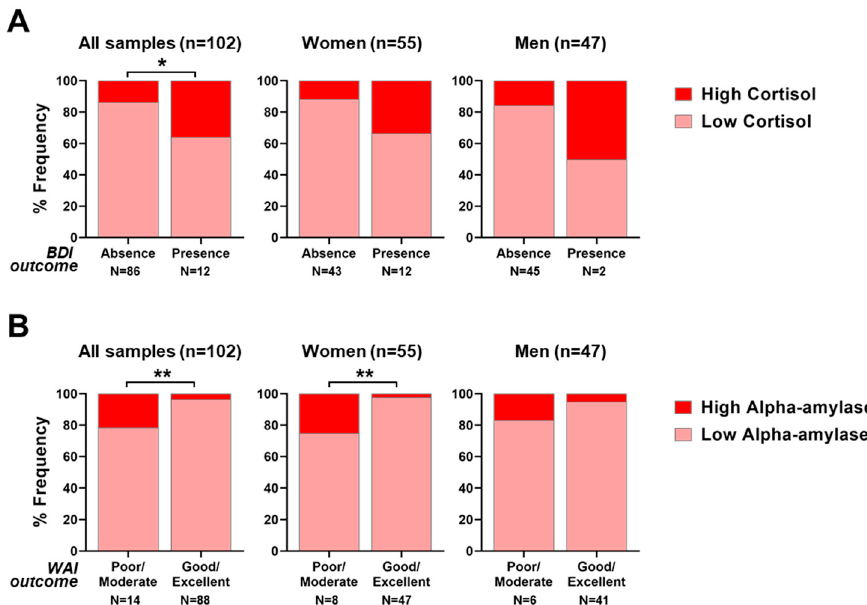
Figure 6. Contingency analyses of psychodiagnostics questionnaires and salivary biomarkers. ( A ) Beck Depression Inventory (BDI) outcome (absence versus presence of depressive symptoms, respectively, left and right columns) in individuals with high (red) versus low (pink) cortisol; considering all samples (left plot), female group (middle plot), male group (right plot). ( B ) Work Ability Index (WAI) outcome (poor or moderate work ability versus good or excellent work ability, respectively, left and right columns) in individuals with high (red) versus low (pink) alpha-amylase; considering all samples (left plot), female group (middle plot), male group (right plot). * p < 0.05; ** p < 0.01. Table 6. Contingency analyses between perceived sleep quality scales and salivary